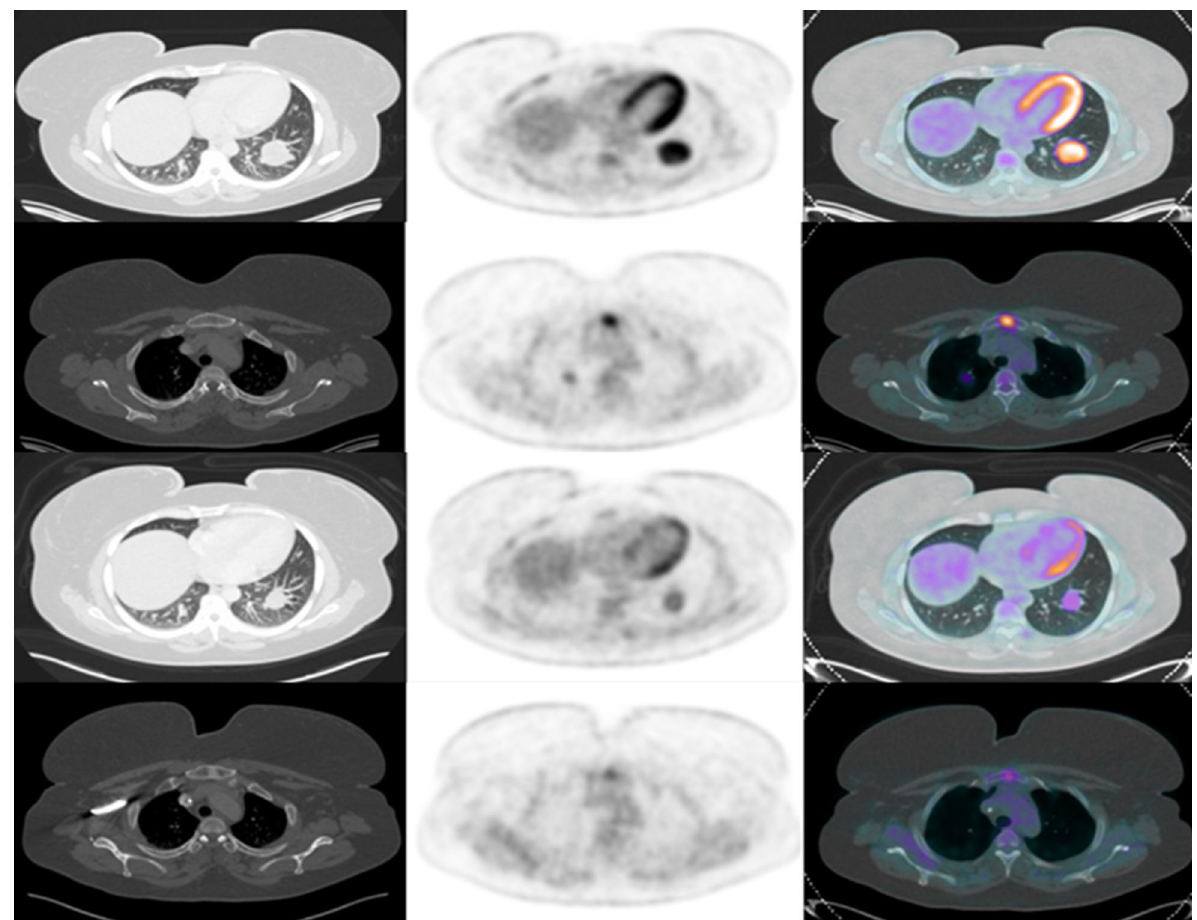
Fig. 2 52-year-old woman with biopsy proven colon cancer. The upper two rows represent the baseline and the lower two rows represent the follow up scans: the left side images are CT cuts at the chest in mediastinal and lung window, the middle images are PET cuts at the same level as on the CT images and the RT images are fused PET/CT images. Of the PET/CT scan revealed two active metabolic metastatic lesions in the lower lobe of the left lung and the sternum. Following therapy PET/CT scan (bottom two rows) demonstrated significant reductions in the size